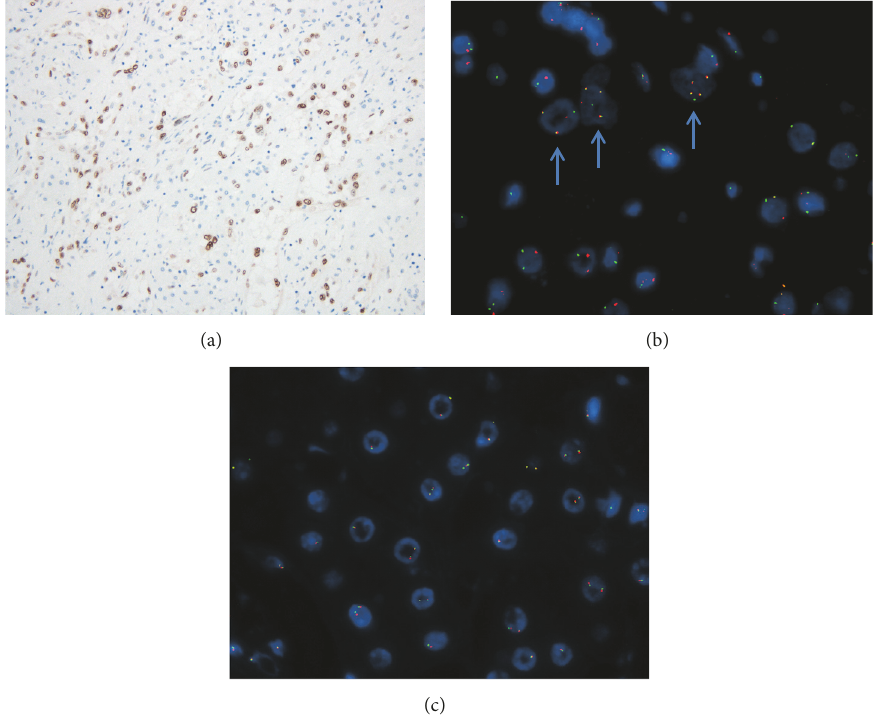
Figure 3: (a) Nuclear TFE3 expression by the neoplastic cells. (b) Dual fusion fluorescent in situ hybridization probes for YAP1 - (spectrum green) TFE3 (spectrum orange) showing fusion of the two loci highlighted by blue arrows. (c) Split apart fluorescent in situ hybridization showing intact